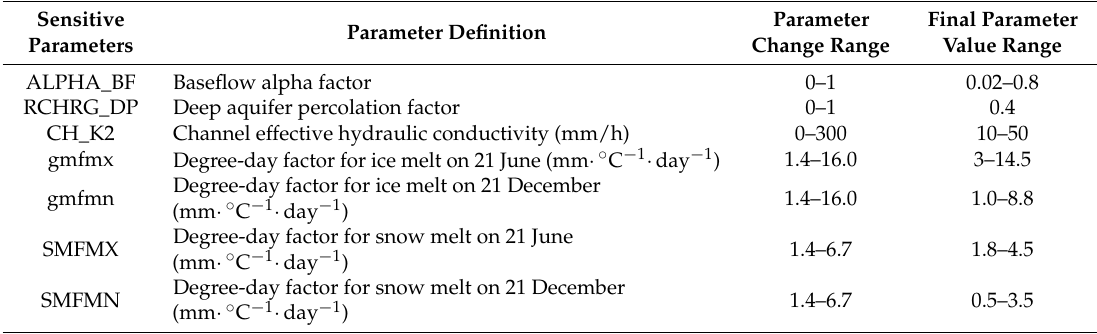
Table 1. The most sensitive parameters and the final calibrated values or ranges of values for the glacier-enhanced SWAT model in the Yarkant River basin